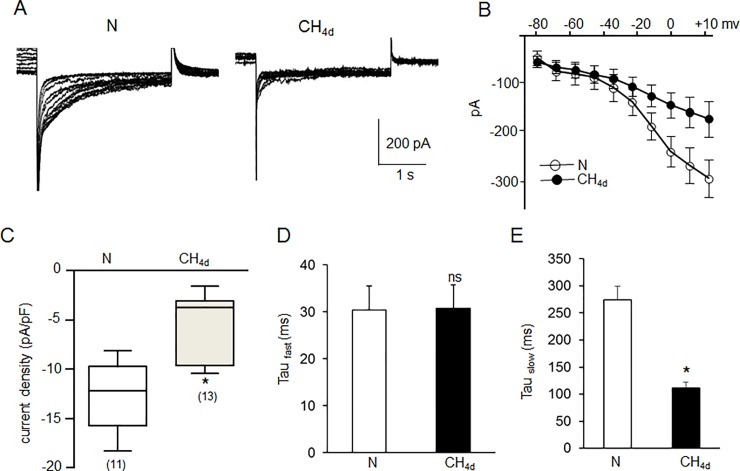
Effect of continuous hypoxia (CH) on hERG-mediated K+ conductance.A) Representative whole-cell currents recorded from cells under normoxia and in cells exposed to CH4d. B) Representative voltage-dependent properties of hERG currents in a control cell (N) and in a cell exposed to CH4d. C) Average data (mean ± SEM) of hERG current densities from cells exposed to normoxia (n = 11) and CH4d (n = 13). Current density was derived by normalizing current amplitudes to cell capacitance. To give a measure of data dispersion, data are presented in box charts, whiskers marking the 5th and 95th percentile and the box determining the 25th and 75th percentile. Arithmetic means are represented by open squares. * denotes p <0.01. D & E) Fast and slow deactivation time constants were compared between normoxia and CH4d exposed cells.